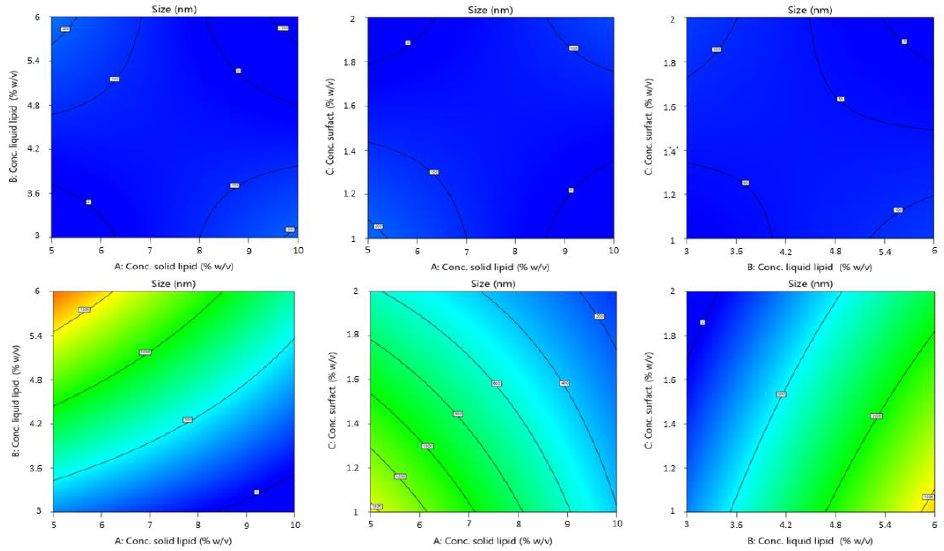
Figure 2. Contour plot of the effect of independent variables (from left to right: solid lipid concn. versus liquid lipid concn., solid lipid concn. vs. surfactant concn. and liquid lipid concn. vs. surfactant concn.) on the size of NLCs using Softisan ® 100 (top) and Gelucire ® 44/14 (bottom row).